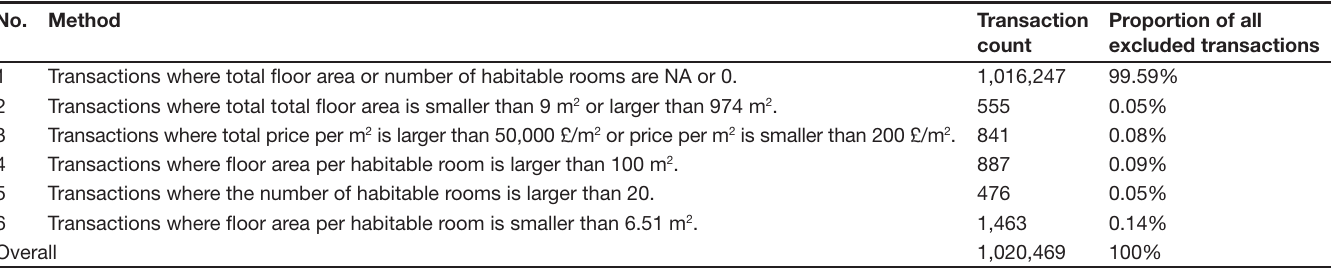
Table 1. List of transactions excluded from the linked geo-referenced data